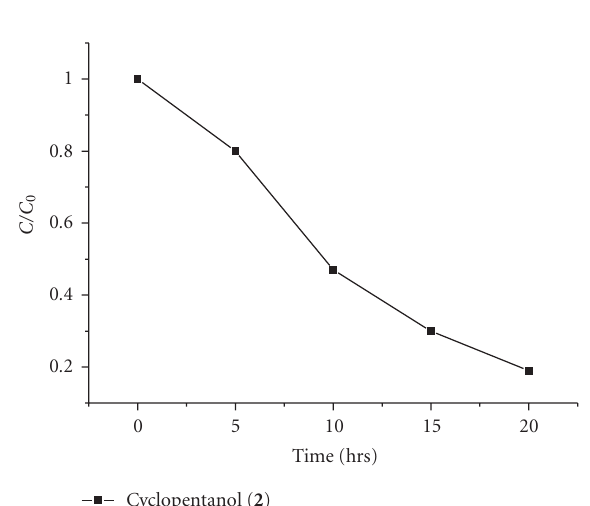
GC chromatogram and the suggested mechanism of these products are similar to the photocatalytic oxidation of cycloheptanol (3)